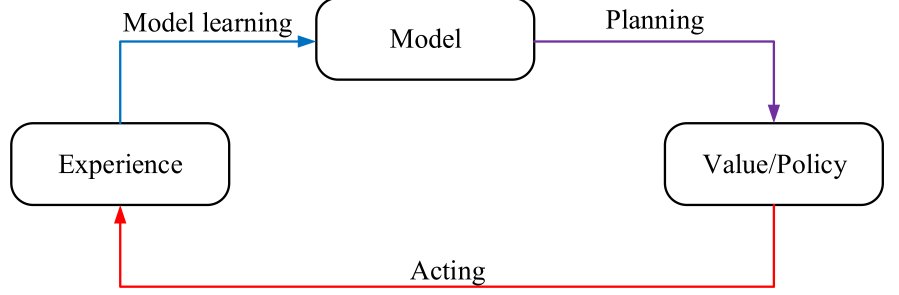
Figure 5. A model-based RL system.